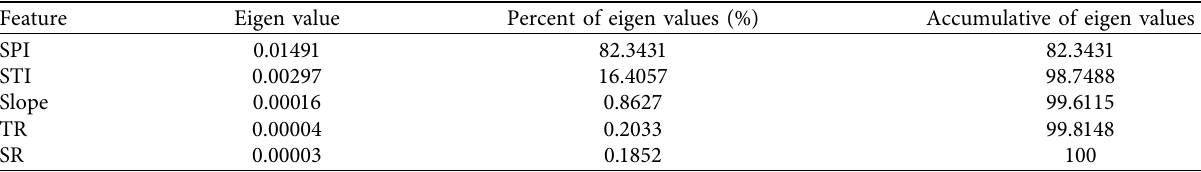
Table 7: Percent and accumulative eigenvalues of the five topographic